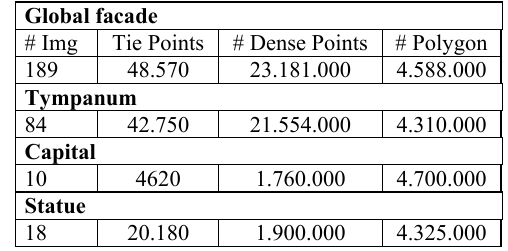
Figure 5. GCPs network distributed on the façade.